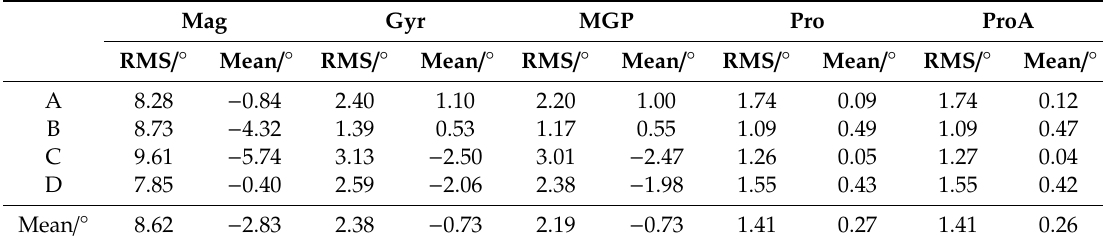
Figure 6. Heading error of local trajectory for XM8: ( a ) Heading error of mark A; ( b ) Heading error of Table 1. The statistic of heading errors for HV9.